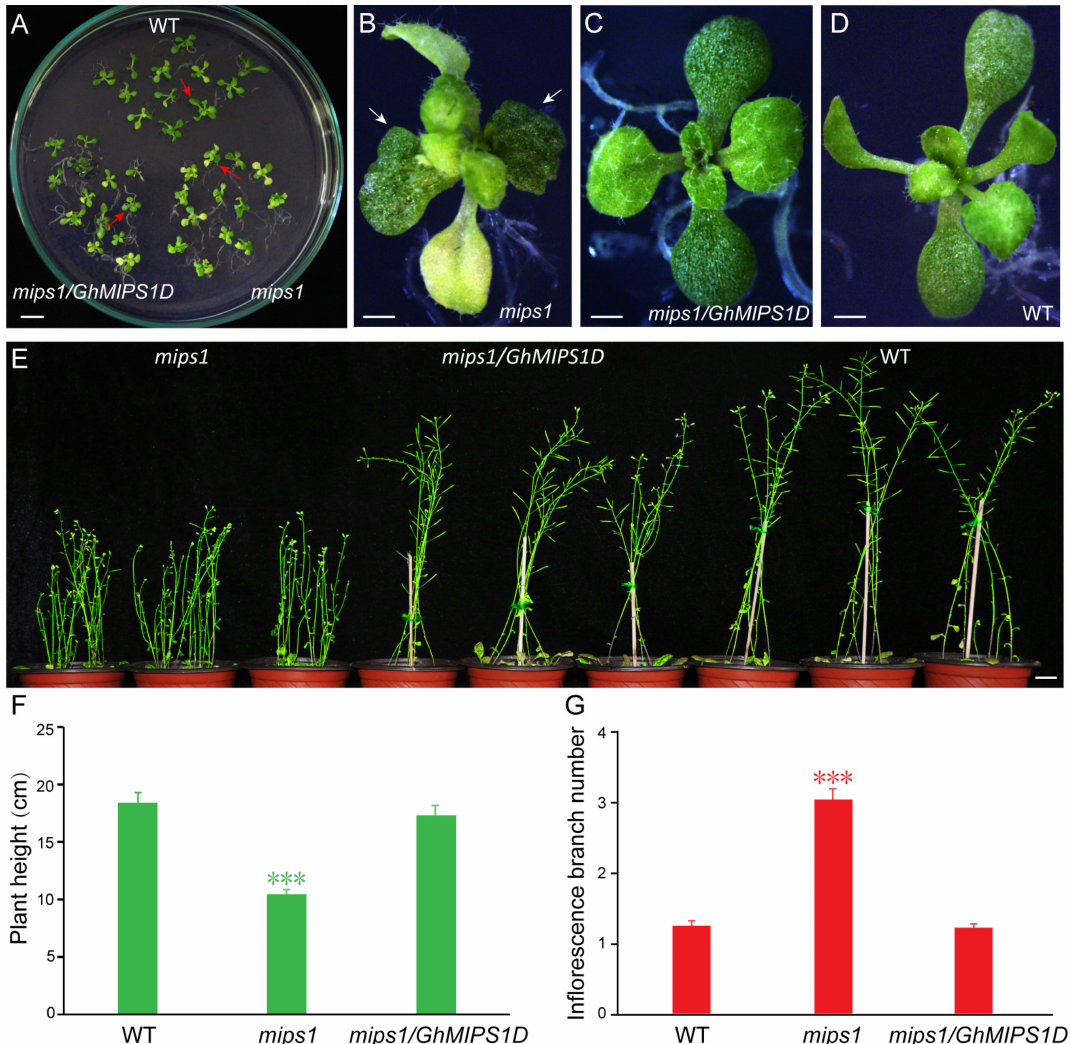
Figure 5. Ectopic expression of GhMIPS1D in Arabidopsis rescues the abnormal defects of mips1 mutants. ( A ) The mips1 mutant ( mips1 ), transgenic ( mips1/GhMIPS1D ) and wild-type (WT) Arabidopsis plants grew on 0.5 × Murashige and Skoog (MS) medium for two weeks. Bar = 1 cm. ( B – D ), the enlarged image of indicated plants (red arrows in ( A )). White arrows indicate the abnormal cotyledon in mips1 mutants. Bars = 1 mm. ( E ) Phenotypes of Arabidopsis plants grew for ten weeks. Significant shorter plants and more inflorescence branches are observed in mips1 mutants, but not in mips1/GhMIPS1D transgenic lines and WT plants. Bar = 1 cm. The plant height ( F ) and the number of inflorescence branches ( G ) are measured ( n = 30). ***, p < 0.001 compared to